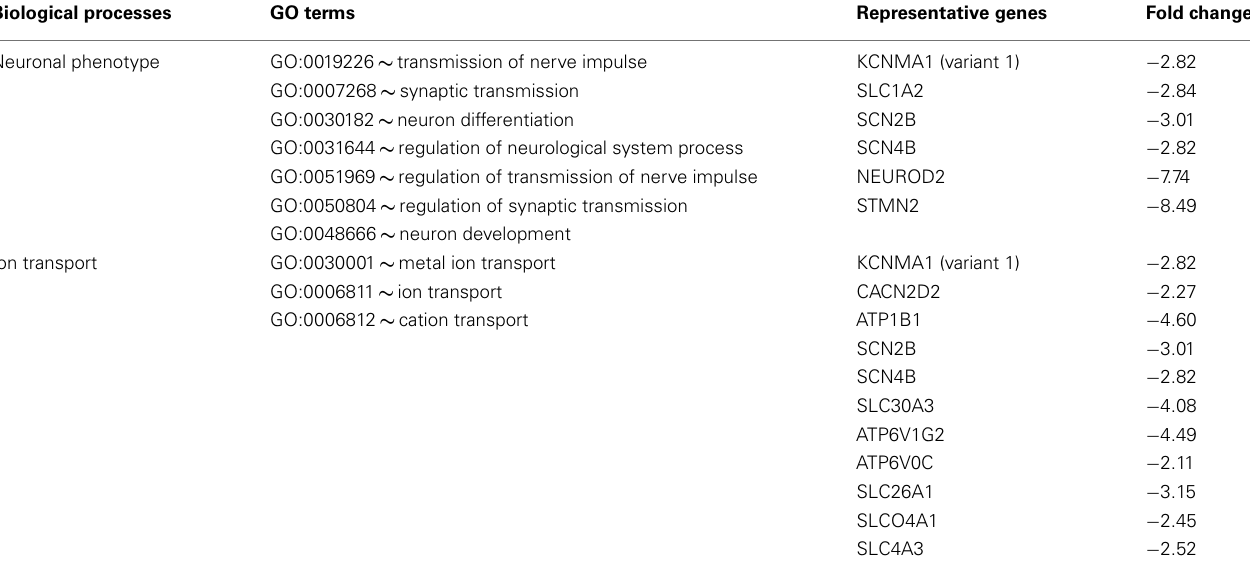
Table 3 | Statistically significant biological processes, associated to the downregulated genes only, represented by DE GO terms in our cohort of glioma